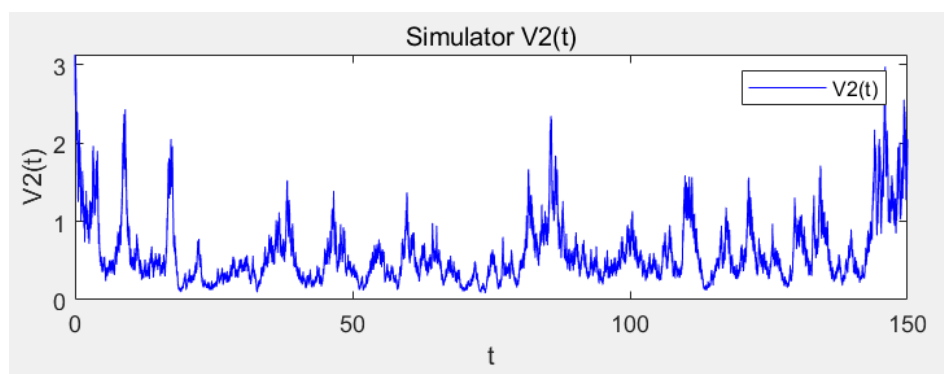
Figure 15. Sample path of V1(t).